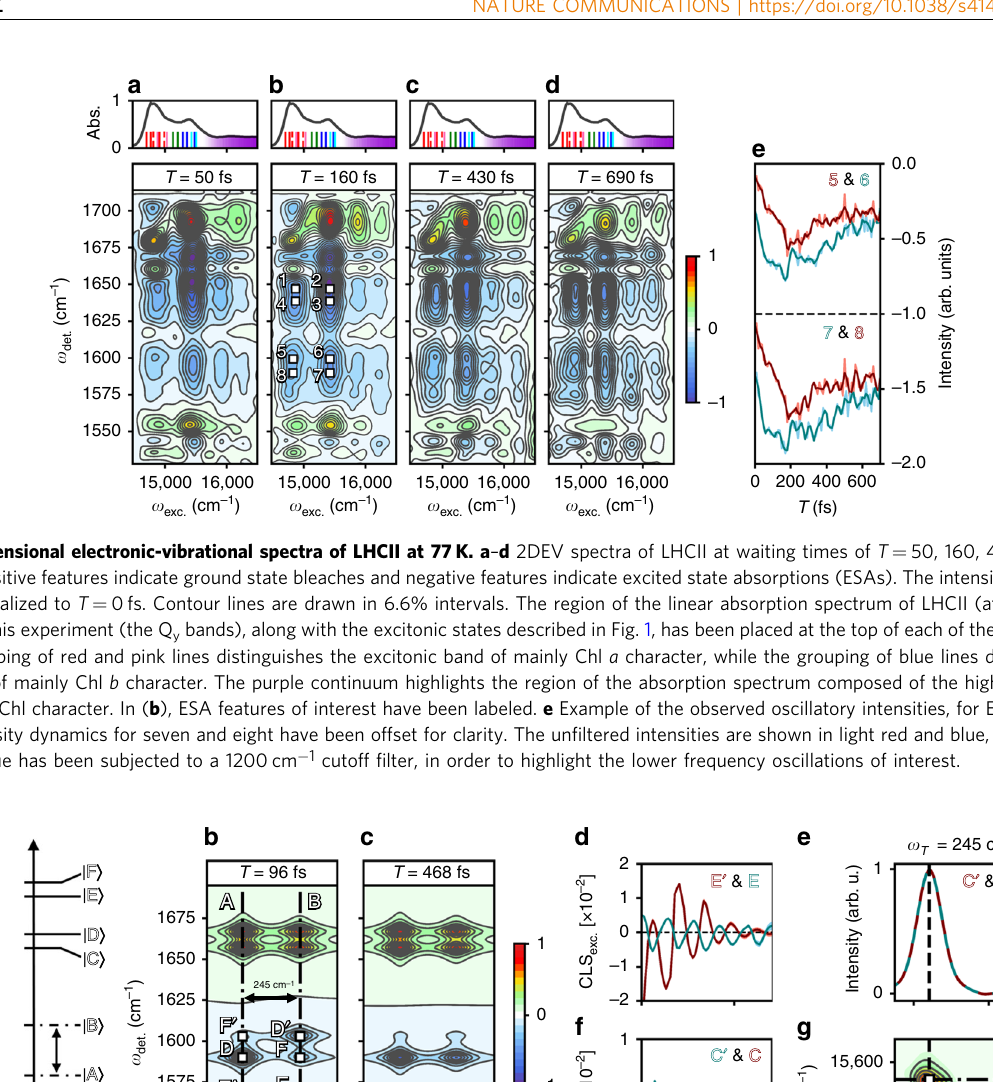
Fig. 3 2DEV spectral evolution of a model heterodimer. a Energy level diagram for the six excitonic states of the heterodimer model, where the ground state manifold has been omitted for clarity. b , c 2DEV spectra for the model at T = 96 fs and T = 468 fs. Positive features indicate ground state bleaches and negative features indicate excited state absorptions. All spectra have been normalized to T = 0 fs. Contour lines are drawn in 8.3% intervals. Features of interest have been labeled C, D, E, F, C ′ , D ′ , E ′ , and F ′ . The two bands along the excitation axis have been marked by dashed-dotted black lines and labeled by the excitonic state that they originate from ( A and B ). The j A i to j B i energy gap has also been labeled. d , f Center line slope dynamics along the excitation axis (CLS exc. ) of certain features, colored according to the peak labels in the top right corner of each plot. e Magnitude of the cross-power spectrum of the CLSs of features C ′ and C, where the oscillatory frequency of 245 cm − 1 is marked by a dotted black line (a peak in the cross-power spectrum indicates a shared frequency). g Intensity beat map along the excitation axis of features C ′ and C, where the oscillatory frequency of 245 cm − 1 is marked by a dotted black line and the involved excitation frequencies are labeled and marked by black dotted-dashed